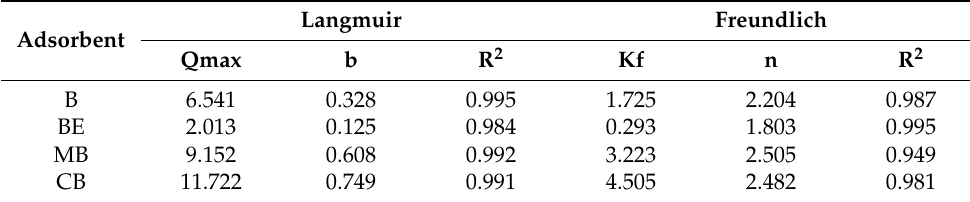
Table 3. The regression parameters of the isothermal adsorption model. Adsorbent